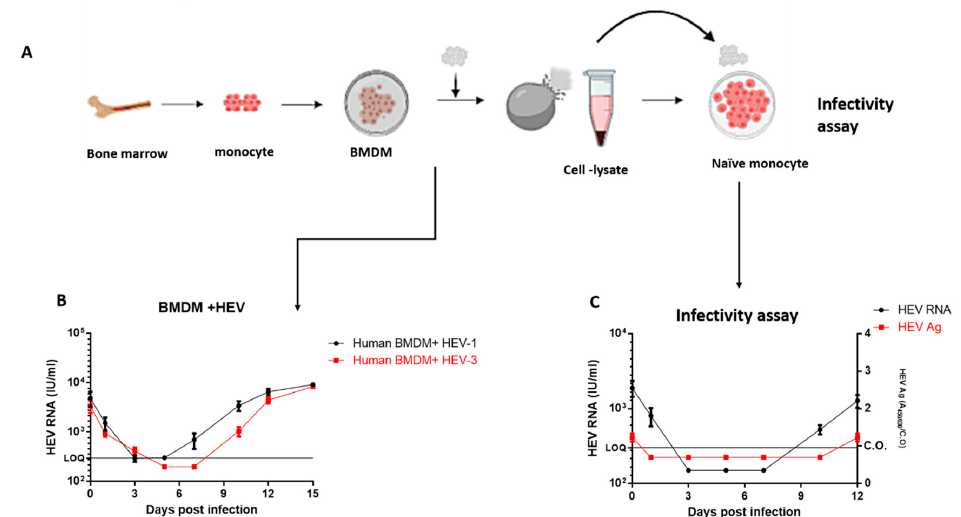
Figure 4. Infection of human BMDMs with HEV inoculums ( A ) Schematic flow showing differentiation of macrophages from bone marrow and preparation of cell lysate for infectivity assay ( B ) Infection of human BMDMs with HEV-1 (black) and HEV-3 (red) inoculums. Extracellular HEV RNA was quantified in the supernatants by qPCR. LOQ: limit of quantification. Depicted are the mean values of three independent experiments ± SEM. ( C ) HMOs were inoculated with cell lysate derived from BMDM on day 15 pi that contained HEV-1. HEV RNA (black; IU/mL, left Y -axis) and HEV ORF2 Ag (red; A 450/630 /C.O., right axis) were measured at different time points after infection. LOQ: limit of quantification. C.O.: cut-off.